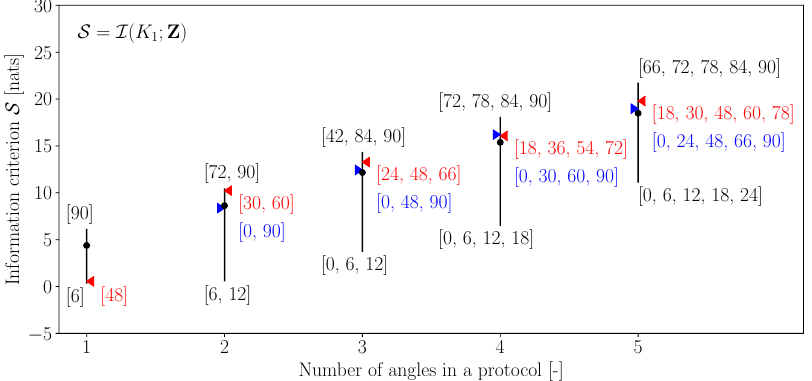
= ( K ) across the 6884 combinations grouped Figure 2. The variation of information criterion 1 ; Z S I by the number of angles in a protocol. The vertical lines represent the variation around the mean value, which is shown in black circles. Black text shows the combinations that produce maximum and minimum values of . The red and blue pointers show for angle combinations that follow a S S uniform discretisation of the angular space between 0 and 90 degrees. Red and blue texts show the associated angle